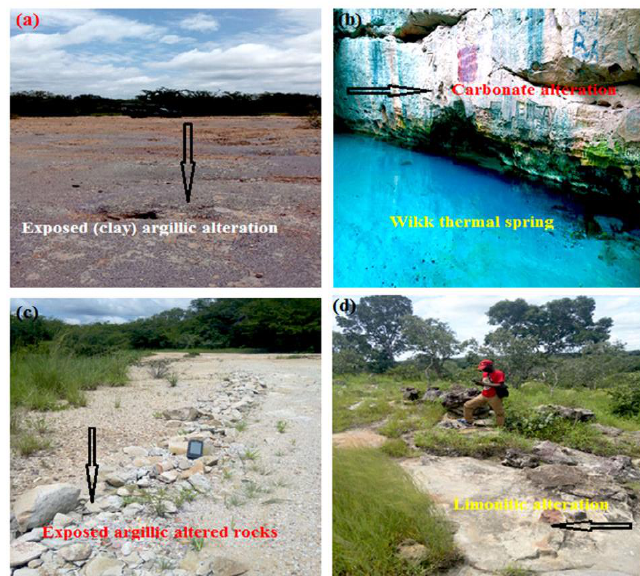
Figure 5. Field photographs of hydrothermal alteration mineral zones associated with the geothermal systems; (a) Exposed clay (argillic) alteration zone around Mawulgo thermal spring;(b) Carbonate alteration at Wikki thermal springs; (c) Exposed argillic altered rocks around Mawulgo thermal spring; (d) Vegetated areas of altered rocks around Wikki thermal